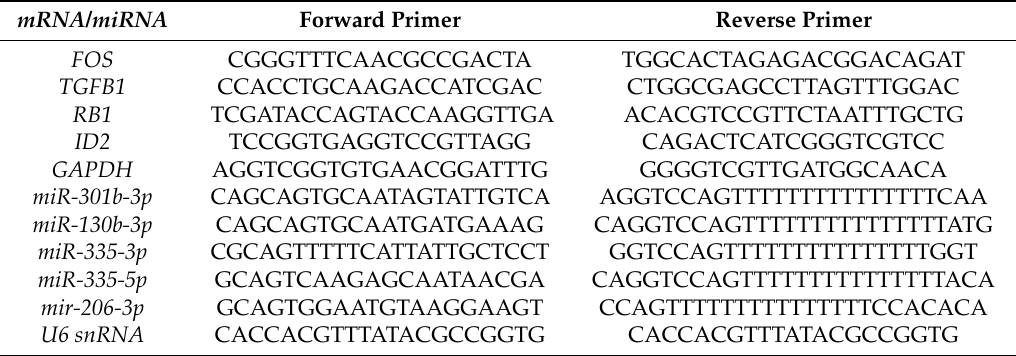
Table 2. Primers for the target mRNAs and